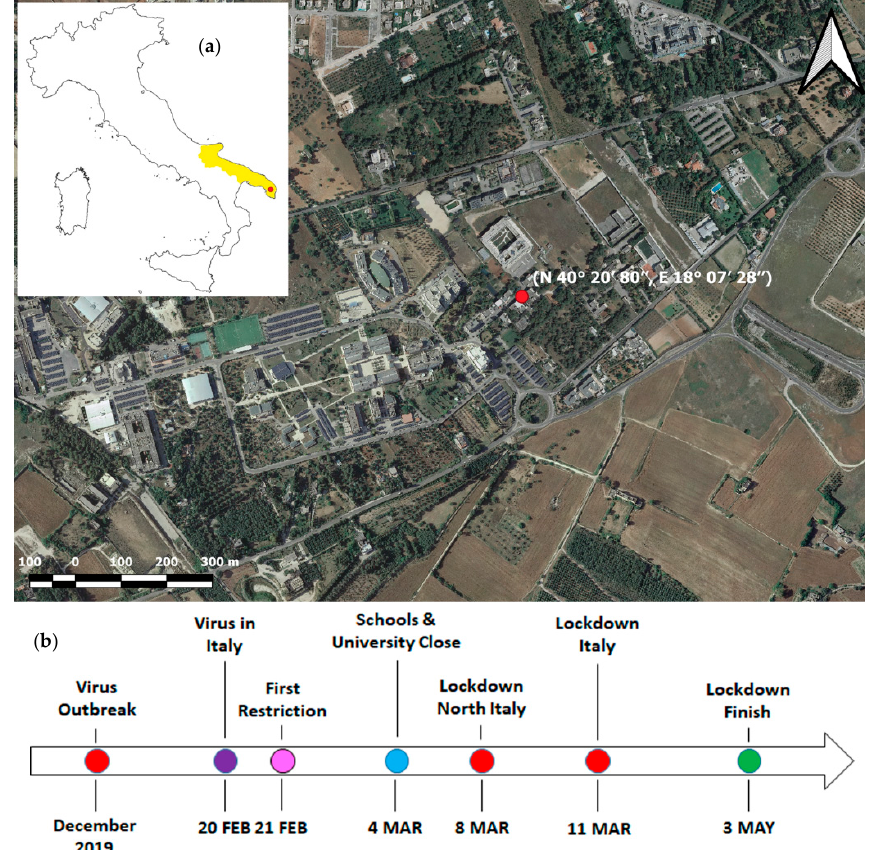
Figure 1. ( a ) A map of the measurement area and the indication of the observation site (red circle). ( b ) Timeline of the significant milestones of 2020, including the starting and closing of the confinement measures taken in Italy during the first six months of the year to prevent infection by COVID-19.